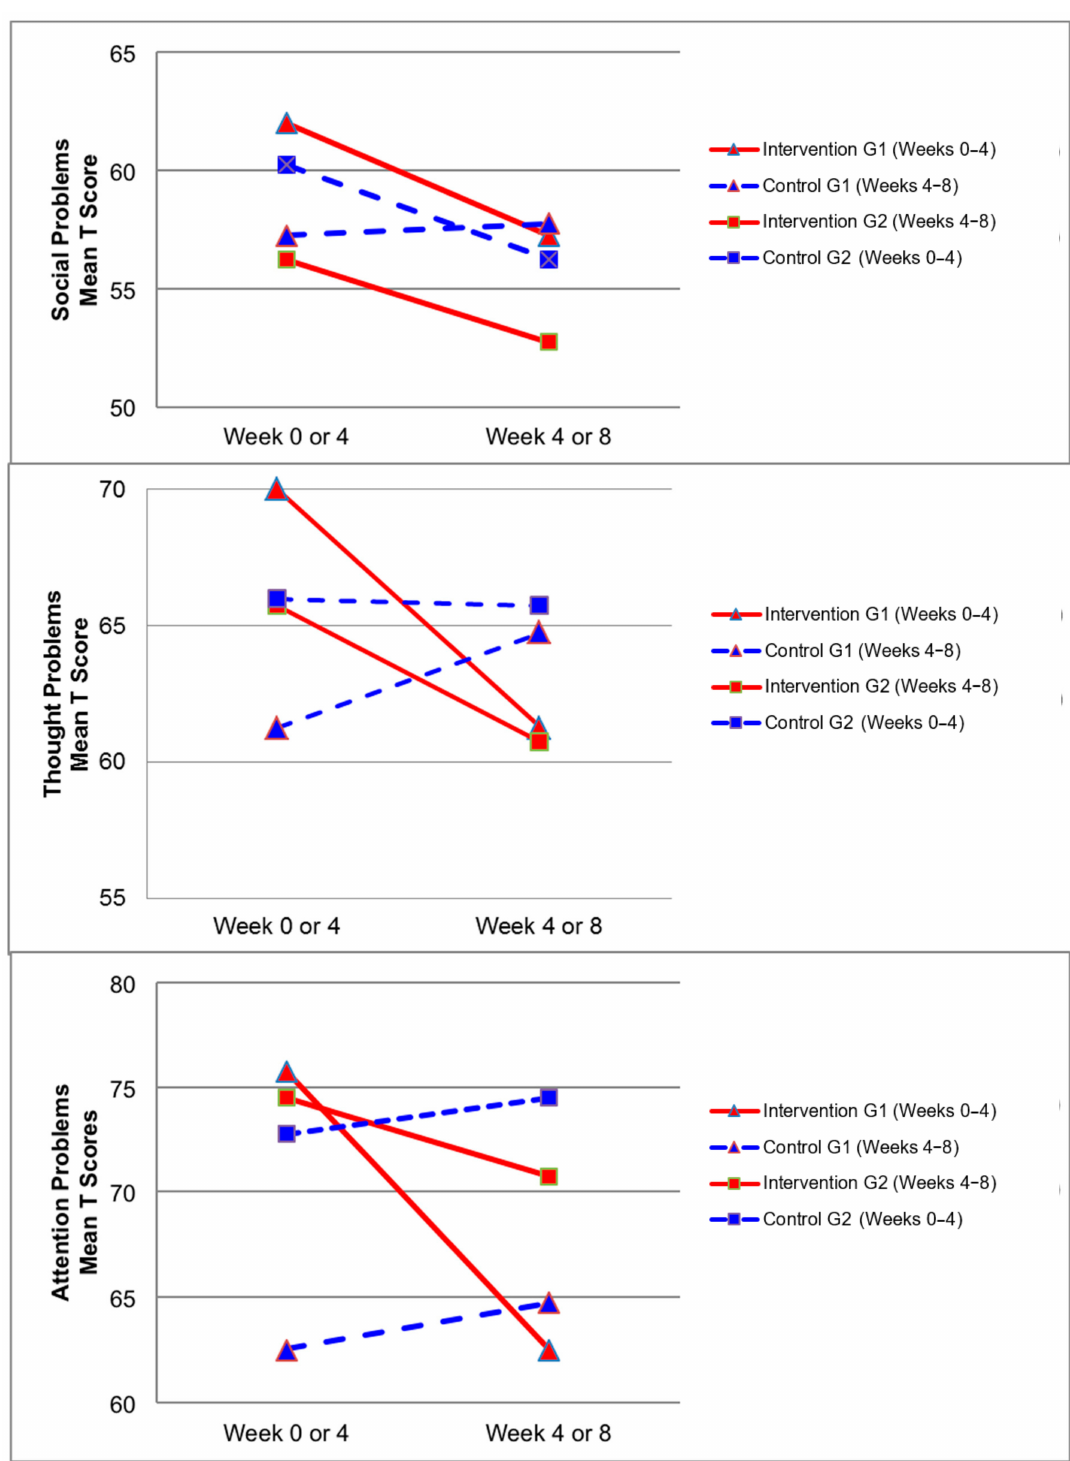
Figure 4. Mean t score changes within Group 1 (G1) and Group 2 (G2) based on intervention vs. control periods for social problems, thought problems, and attention problems